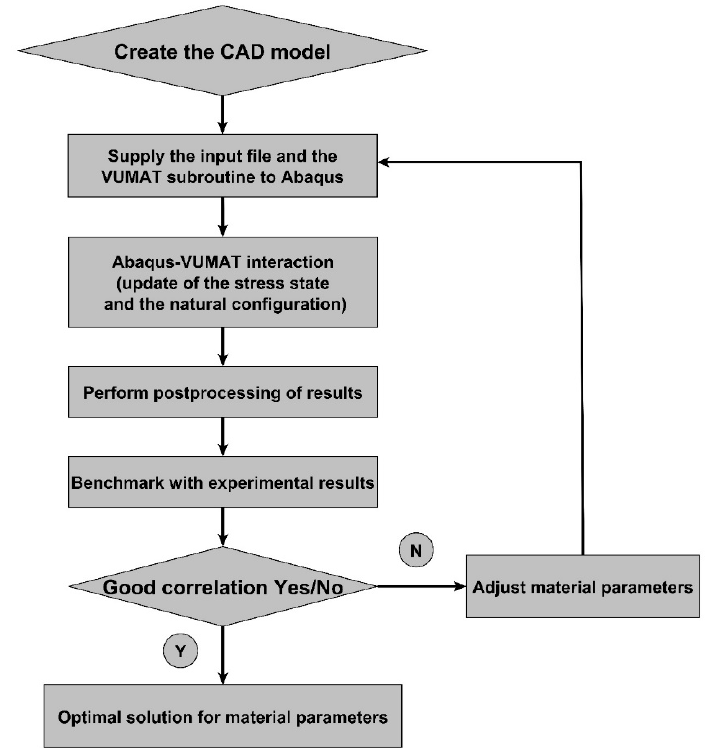
Figure 15. The flowchart of VUMAT subroutine.